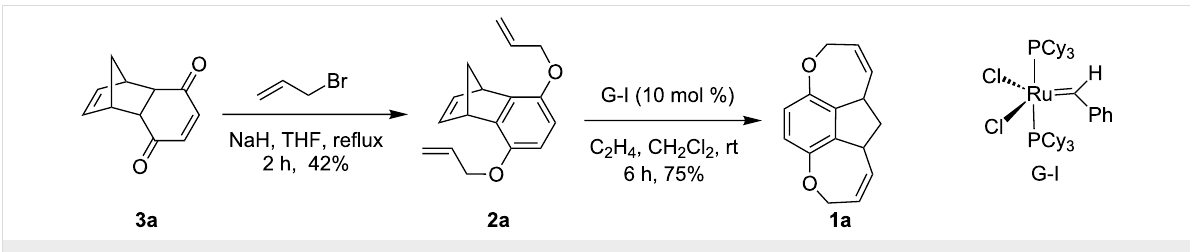
Scheme 1: Synthesis of the oxa-bowl 1a via RRM.